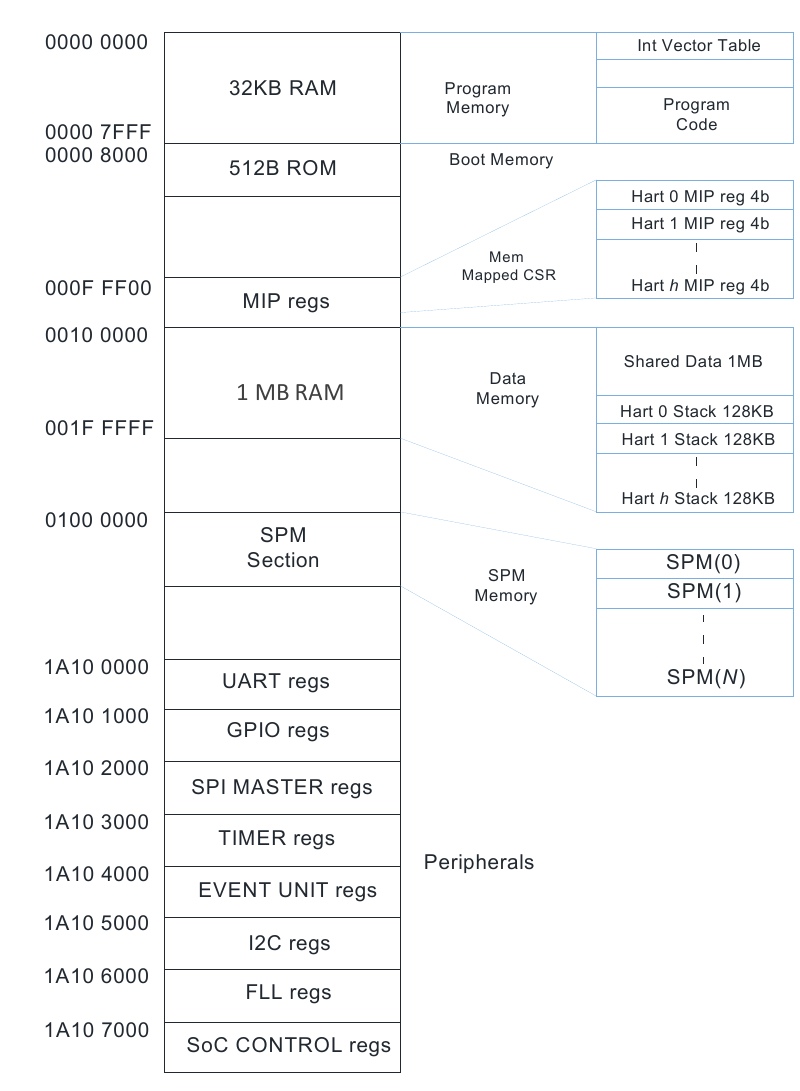
Figure 4. Code for multi-threaded execution on Klessydra-T1.